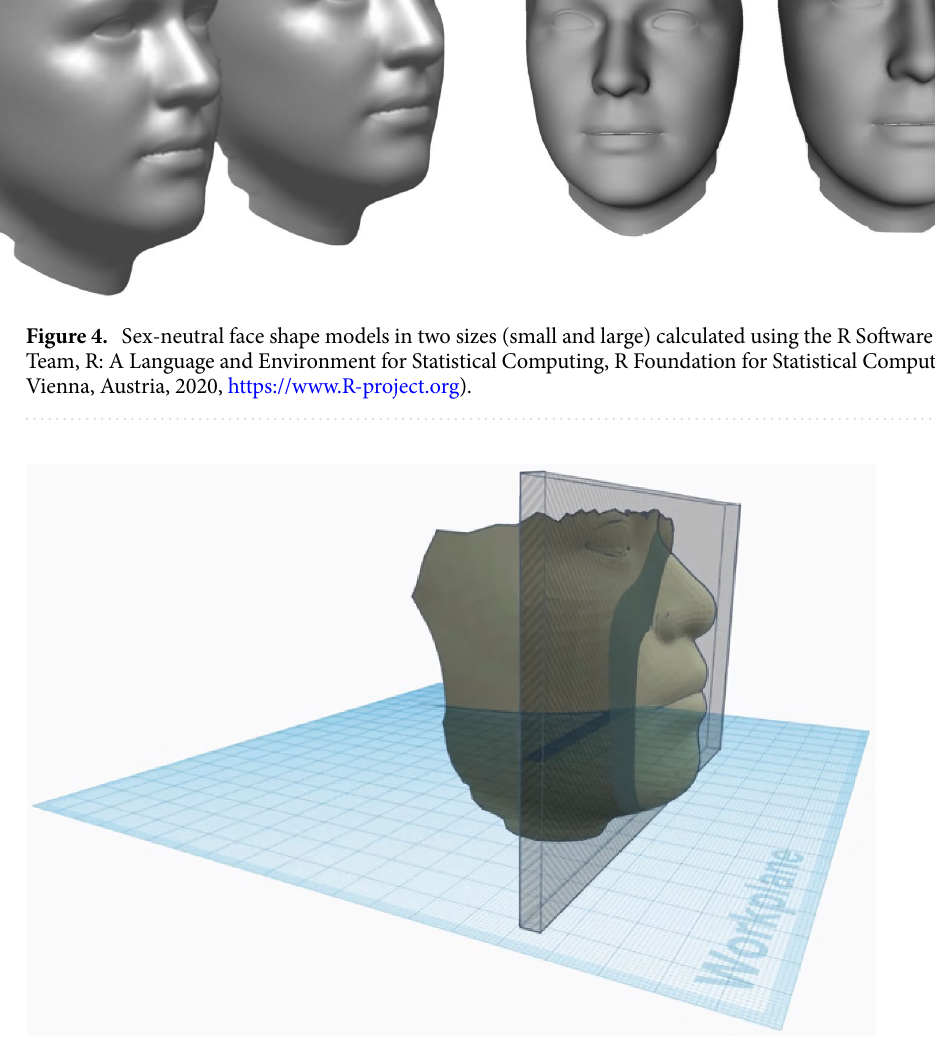
Figure 5. An 8 mm slice ranging from the glabella to the menton is cropped to serve as a precursor for the statistically shaped mask based on the calculated average